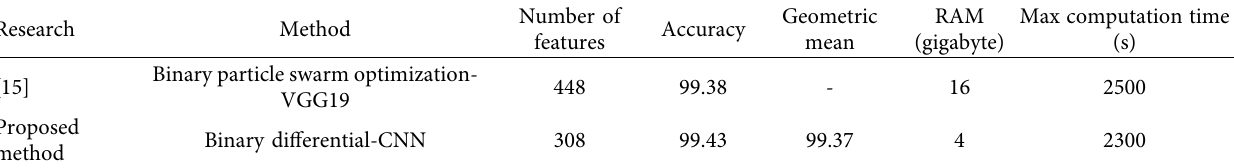
Table 4: A comparison of the proposed method with prior